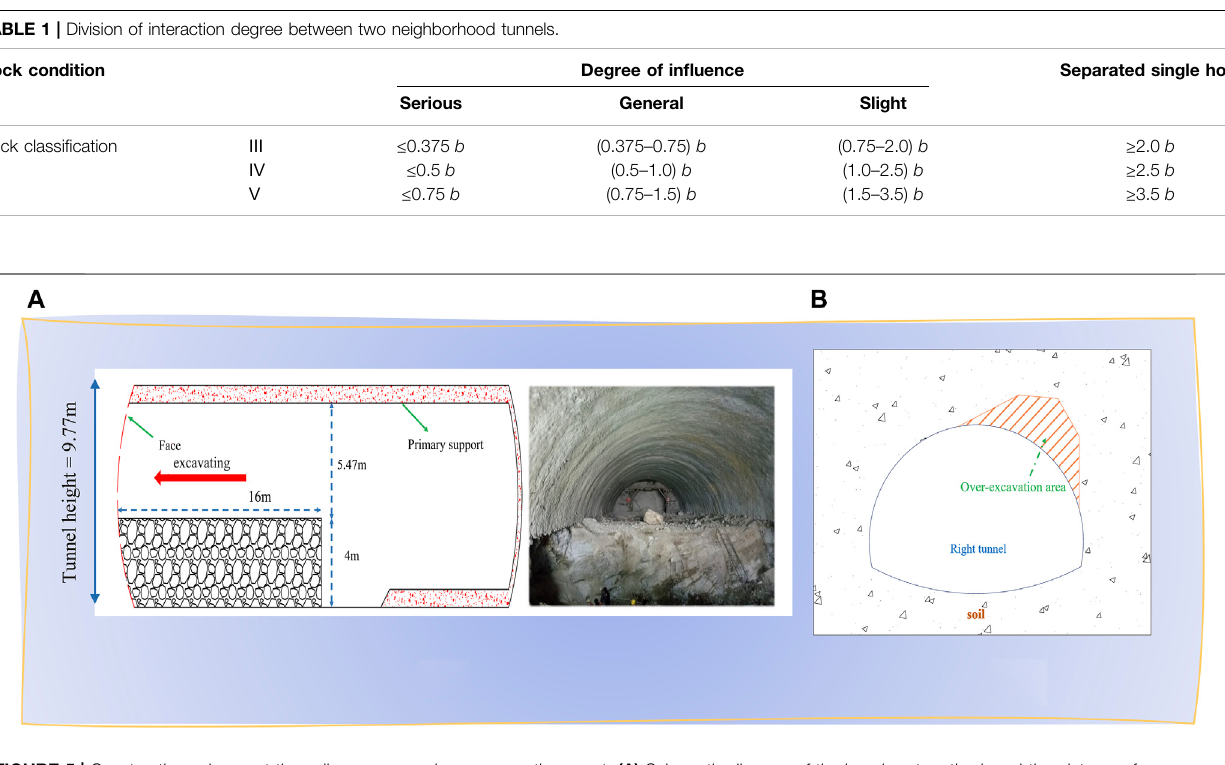
Frontiers in Earth Science |